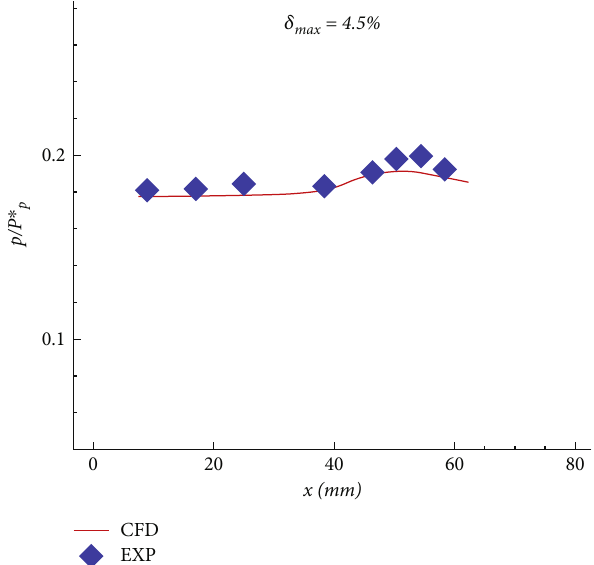
Figure 5: Comparison of the experimental and simulation results ( Ma = 1 : 1 ).